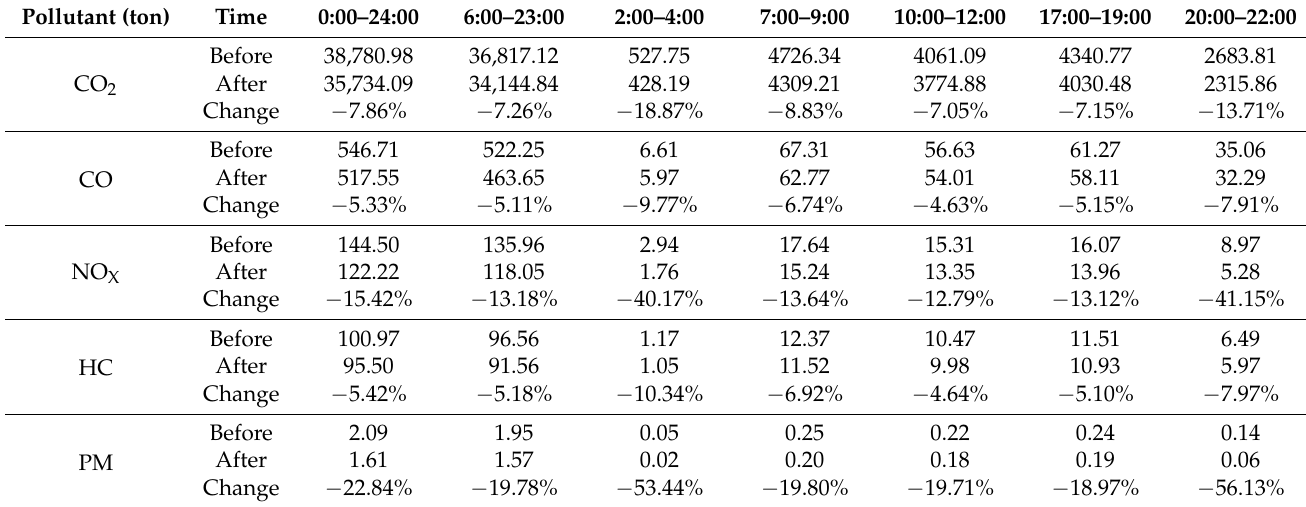
Table 7. The emissions of each pollutant before and after the implementation of the traffic restriction policy in different periods.